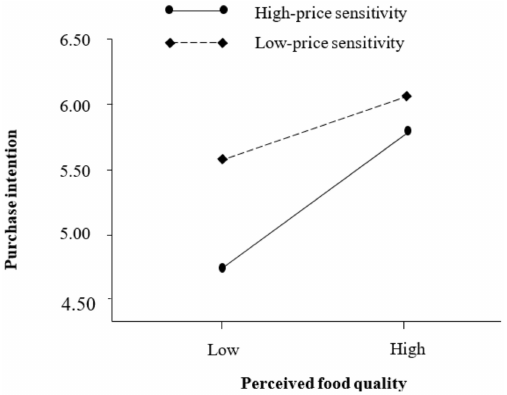
Figure 2. Moderating e ff ect of price sensitivity.